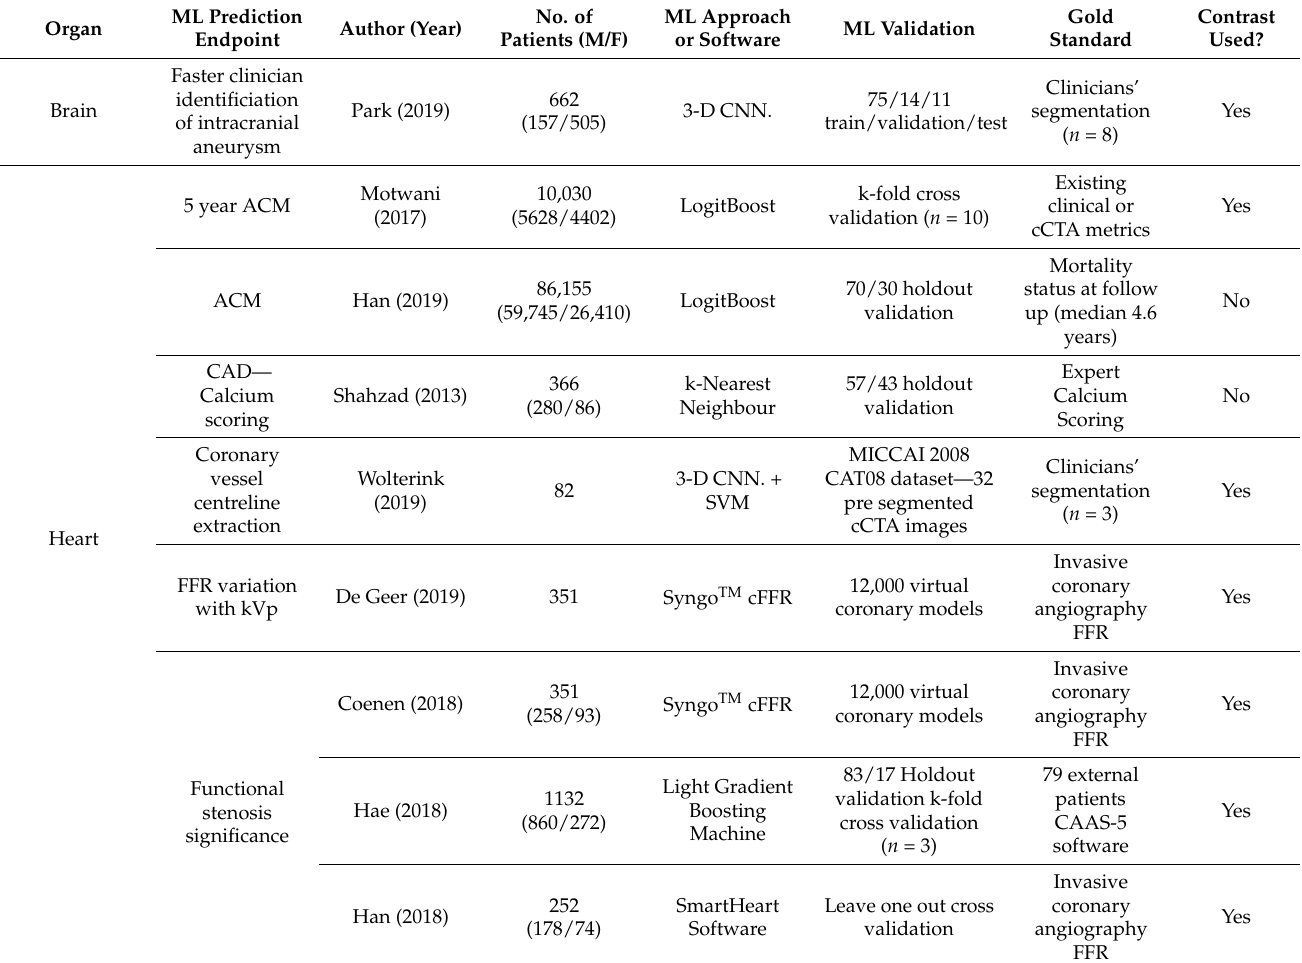
Table 1. Computed Tomography Angiography (CTA)